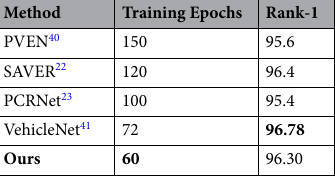
Table 8. Comparison of training efficiency of different methods. Bold indicate the best results for the corresponding metrics.